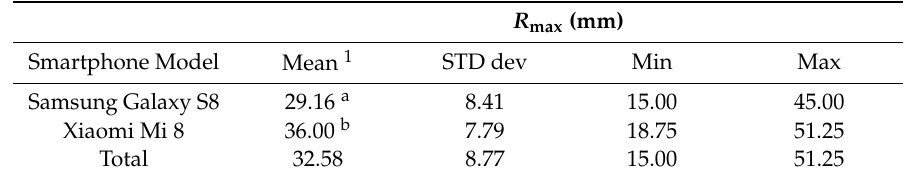
Table 9. Mean of the maximum tag-to-smartphone reading distance ( R max (mm)) with the two smartphones models.